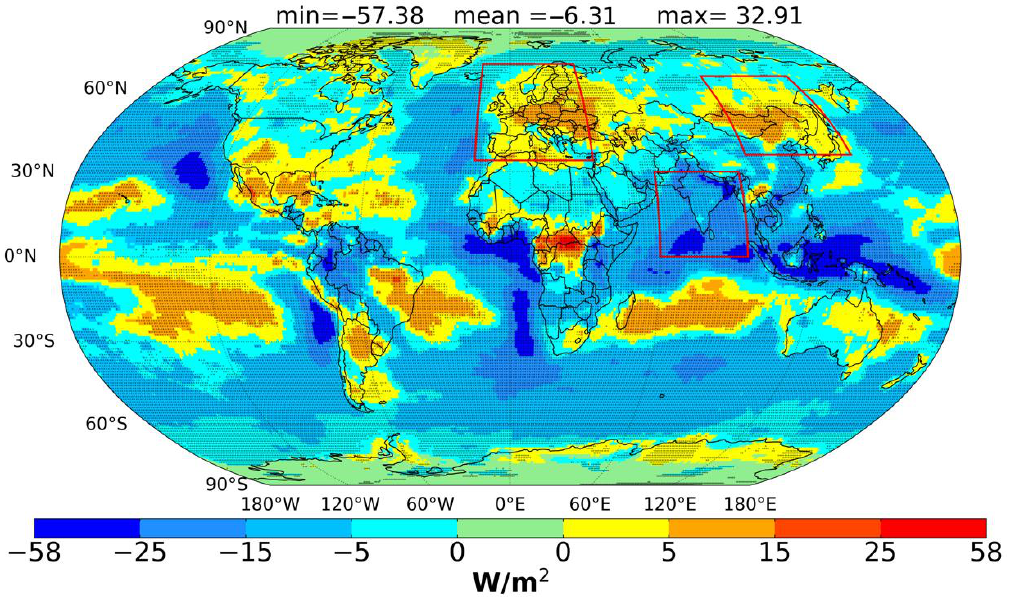
Figure 11. Global distribution of GDB, namely changes of MERRA-2 deseasonalized SSR anomalies, over the 40-year period January 1980 – December 2019. Areas shaded with reddish/bluish colors are those with positive/negative trends (brightening/dimming). Areas (pixels) with statistically significant trends are indicated by black dots. World areas (Europe, India and East Asia) enclosed by red rectangles are characterized by homogeneous SSR trends (reference is made to them below).